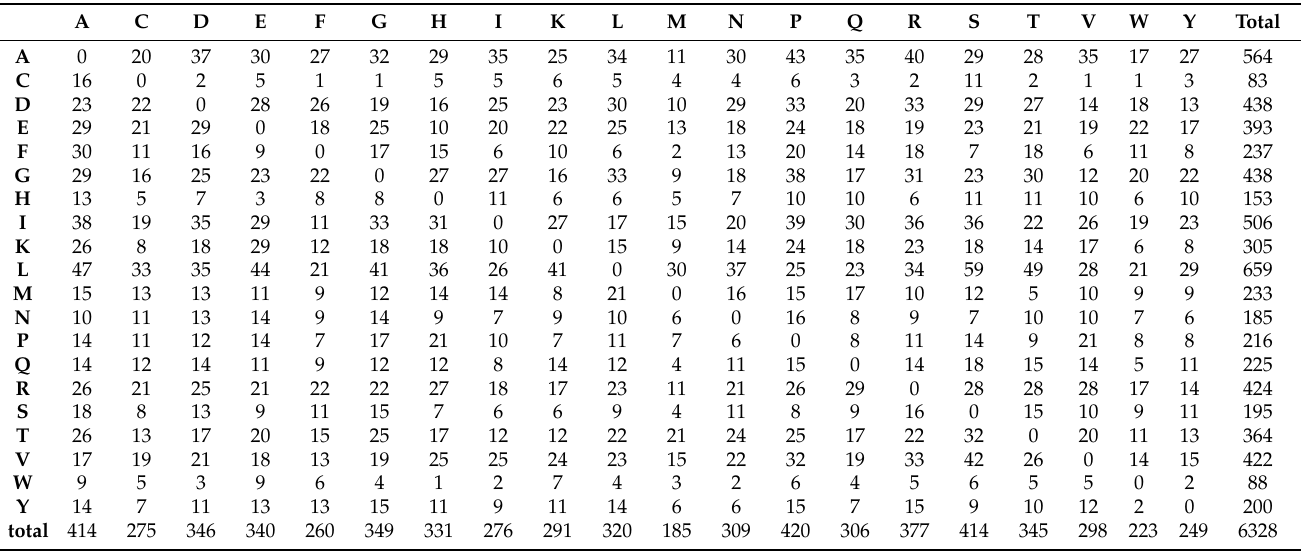
Table 1. Distribution of amino acid residues in the dataset. The original amino acids are in rows and variant residues are in